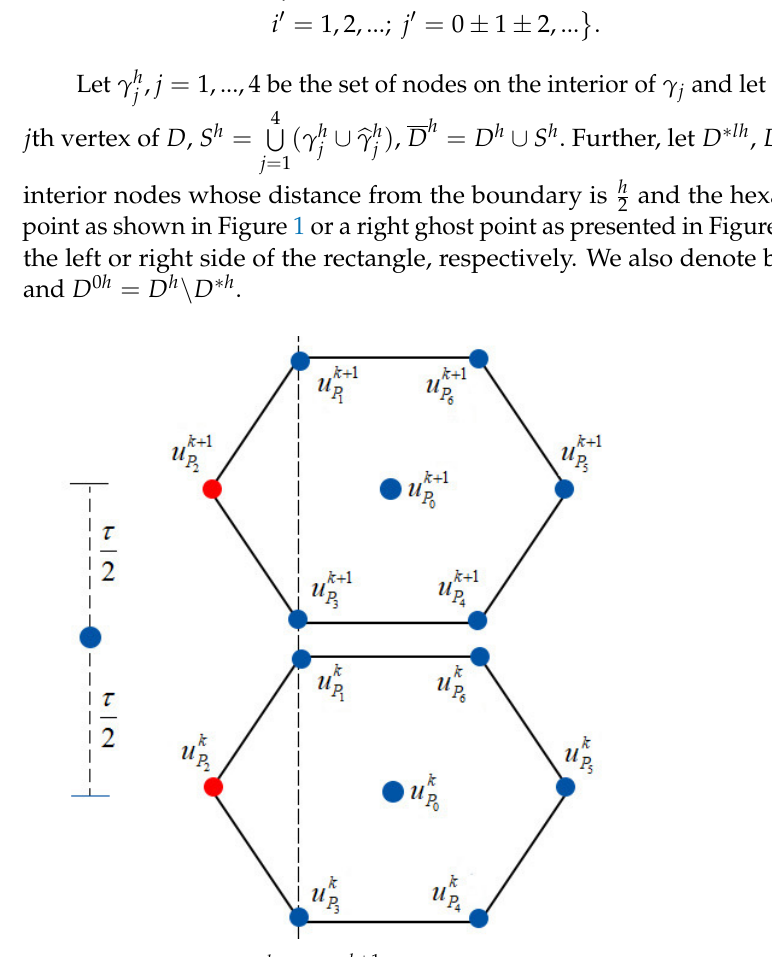
Figure 1. The solution u k